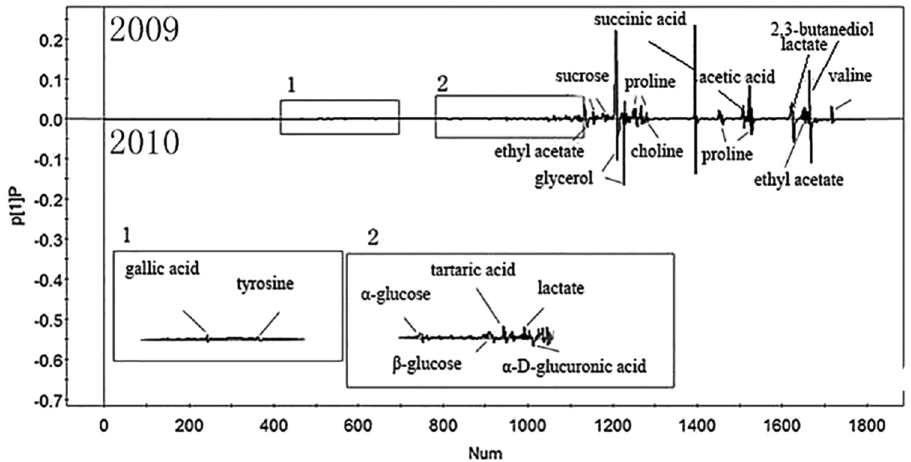
Figure 5: PLS - DA loading plot chart from 1 H NMR spectra of 2009 and 2010 vintage Cabernet Sauvignon